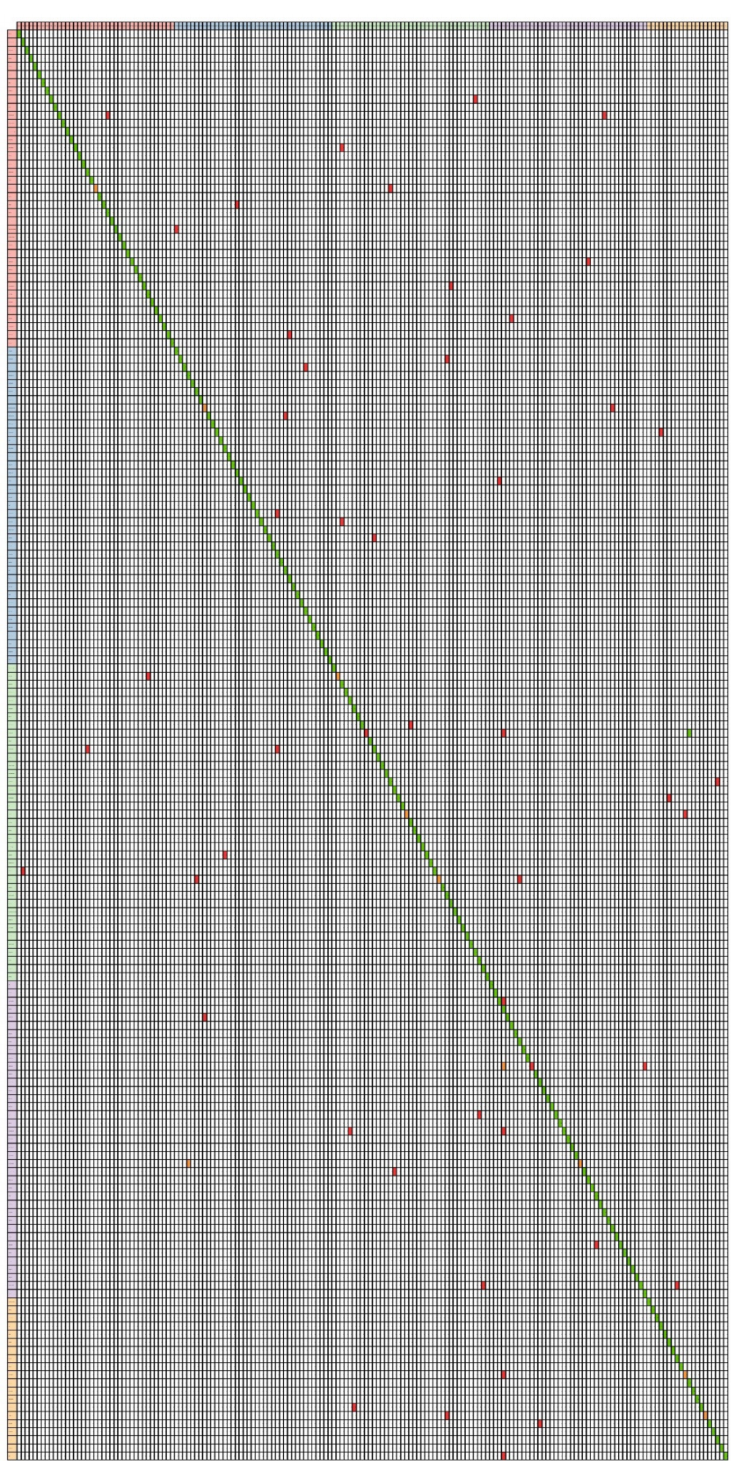
Figure A3. Confusion matrix of 176